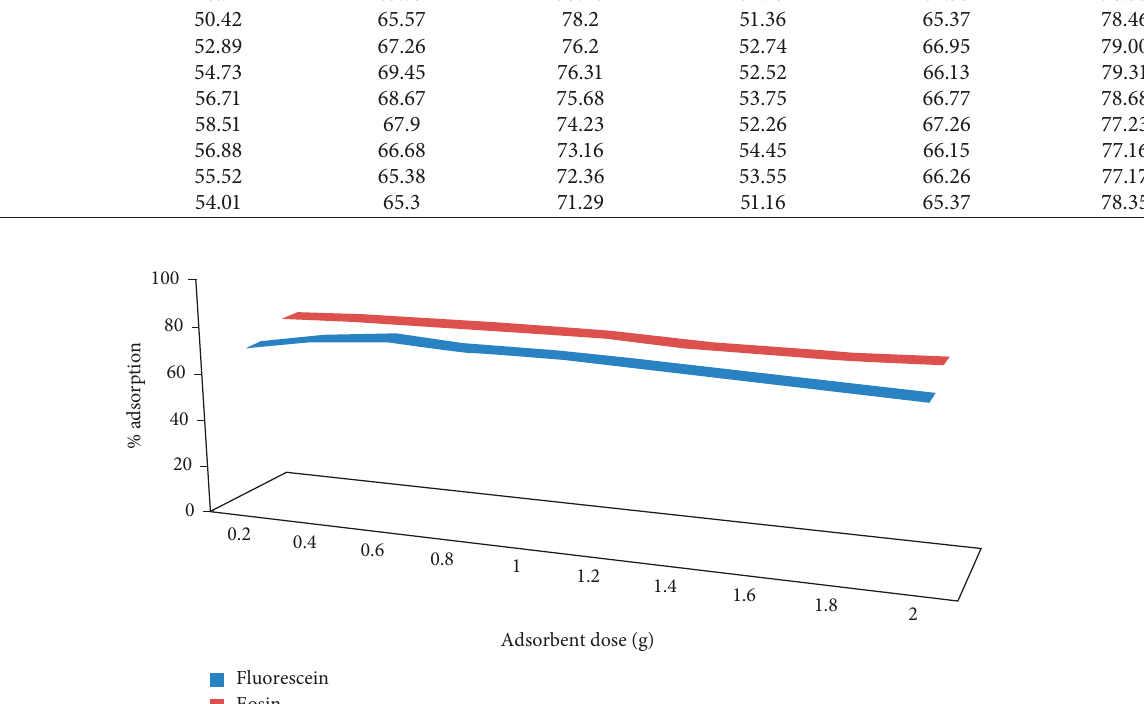
Figure 4: Comparative sorption efficiency of base-treated WMP at different doses for removing fluorescein and eosin dyes. Table 3: Sorption efficiency of the sorbent material (WMP) over a different range of contact time. Contact time